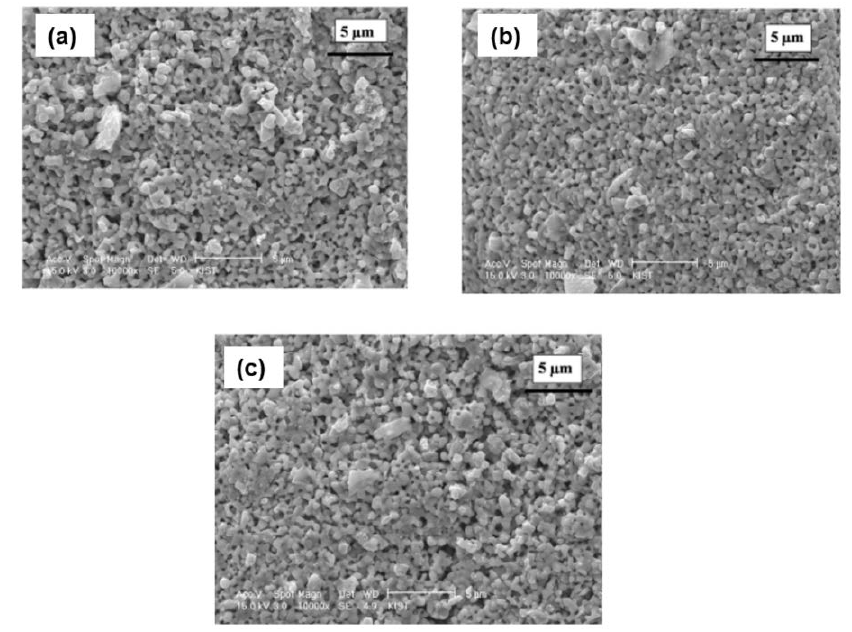
Figure 20. Scanning electron micrographs of Ni-CGO cermet catalysts ( a ) after reduction and after catalytic tests at ( b ) S/C = 0.5 and ( c ) S/C = 1.5 at 800 ◦ C for 5 h (adapted from